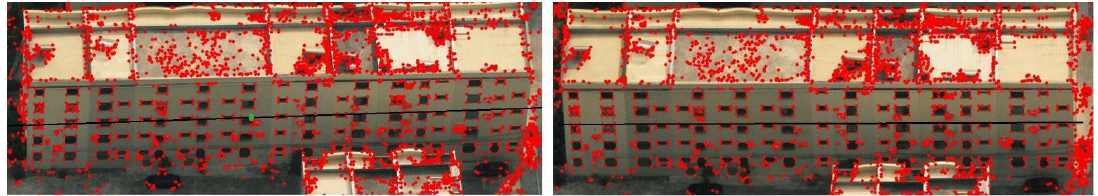
Figure 10. SIFT features detected in binocular vision images.